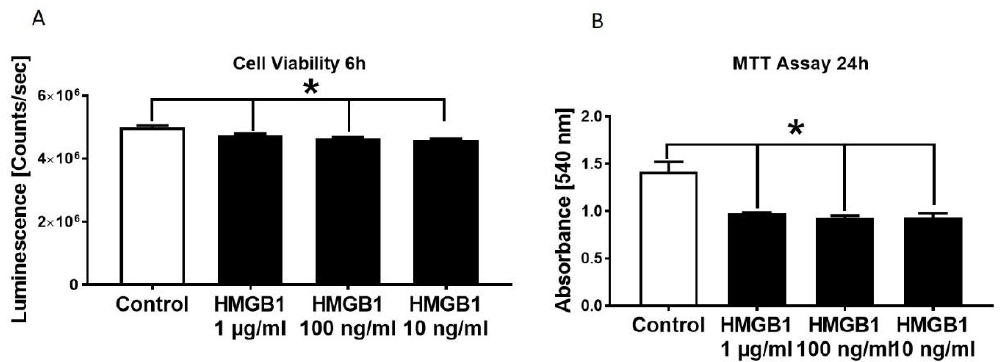
Figure 2. Decrease in HL-1 cell viability and metabolic activity in the presence of di ff erent HMGB-1 concentrations. HL-1 cell viability in the presence of di ff erent HMGB-1 concentrations after 6 h of incubation compared to control-HL-1 cell viability ( A ). Metabolic activity measured in HL-1 cells in the presence of di ff erent HMGB-1 concentrations incubated for 24 h compared to controls ( B ). n = 6. Results were significant * p < 0.05.